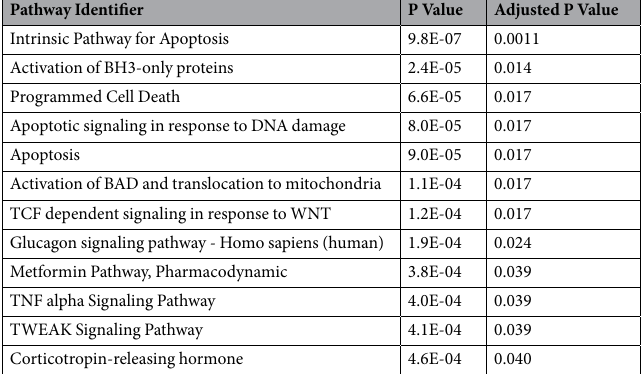
Table 2. Pathway analysis of the log-fold change in protein expression changes with normalised biopotential changes. Pathway enrichment analysis was performed to determine pathways that are significantly altered when comparing protein expression changes between cancerous and non-cancerous samples and biopotential. Correlations between these factors were ranked upon the gradient of the trend observed. All significantly enriched pathways are shown, with apoptosis related pathways being frequently represented.